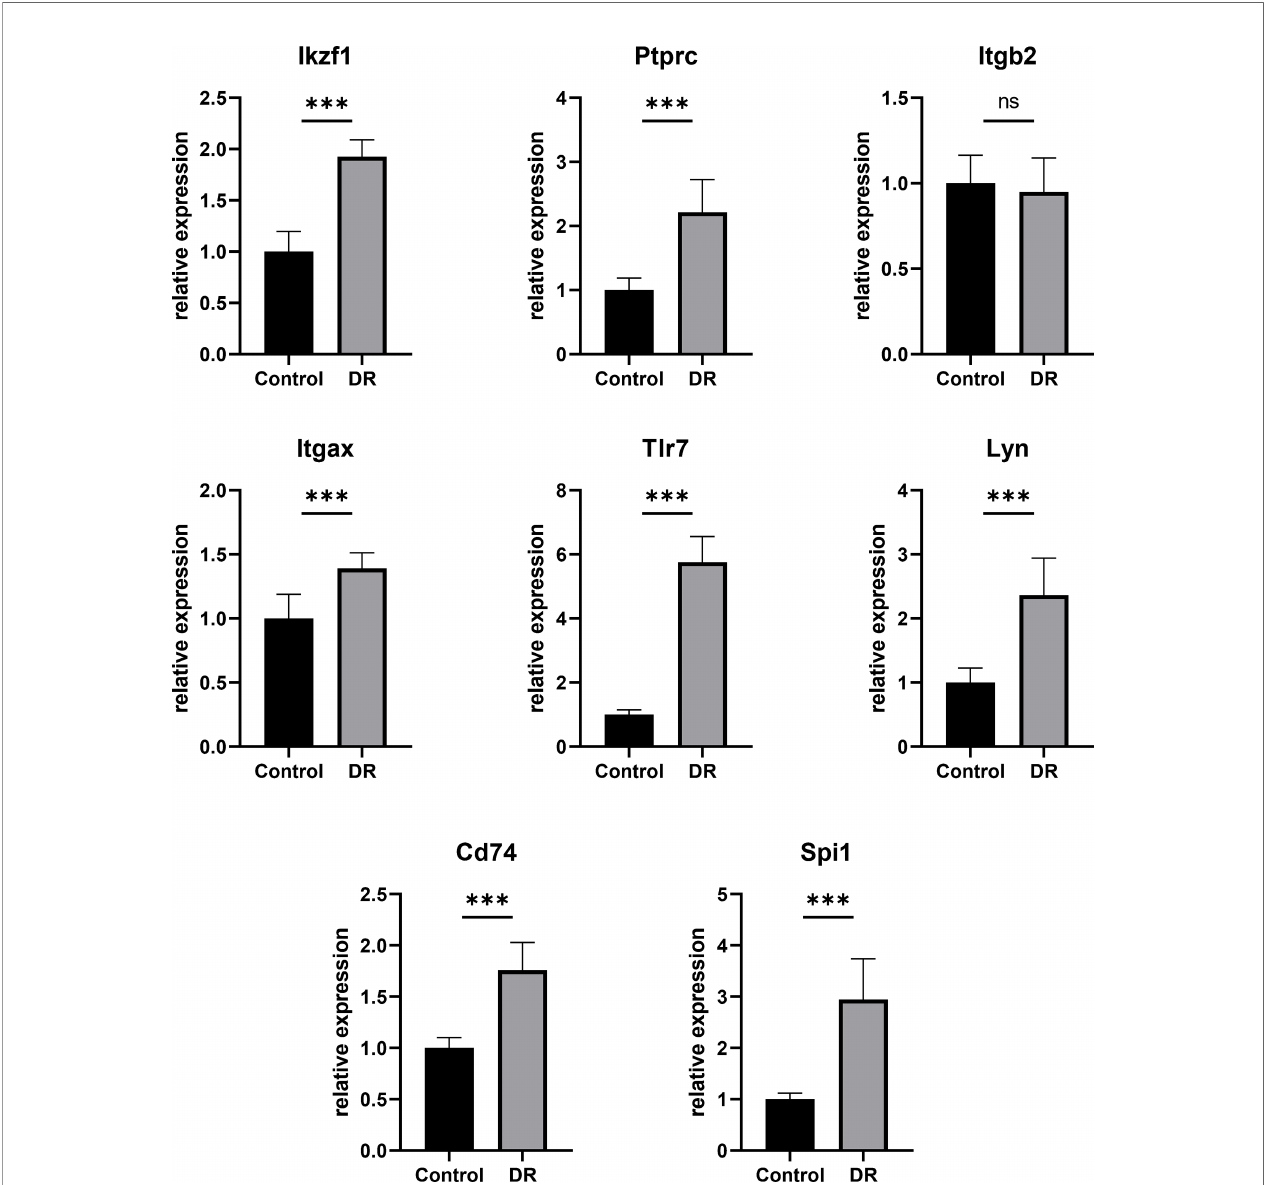
FIGURE 7 | Hub DECD8+TRGs mRNA levels in retinas of DR model mice and control mice validated by qPCR. Compared with the control group, the transcription levels of the other seven Hub DECD8+TRGs in the DR model mouse group except Itgb2 were signi fi cantly up-regulated, while there was no signi fi cant change in Itgb2. ***p < 0.001, NS p >